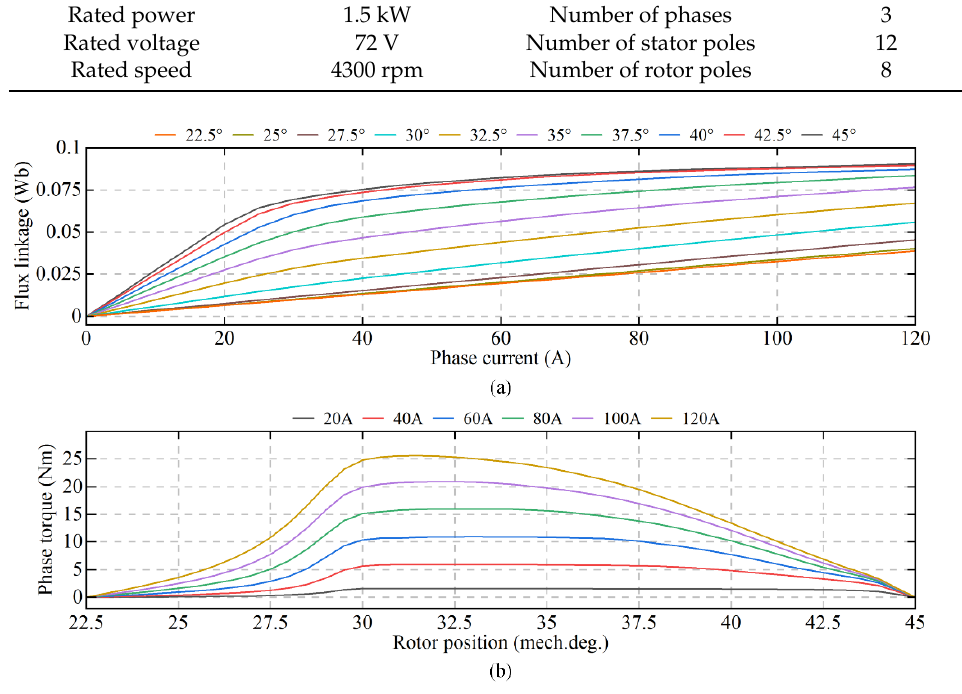
Figure 17. ( a ) Magnetization characteristics and ( b ) torque characteristics of phase A of the three- phase SRM.